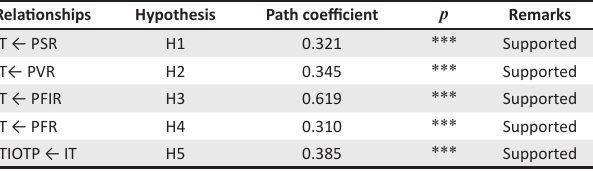
FIGURE 3: Final structural model of the study. TABLE 4: Summary of the hypotheses testing.